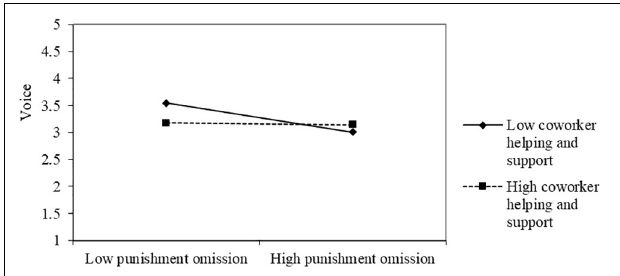
FIGURE 2 | The moderating role of coworker helping and support in the relationship between punishment omission and voice.